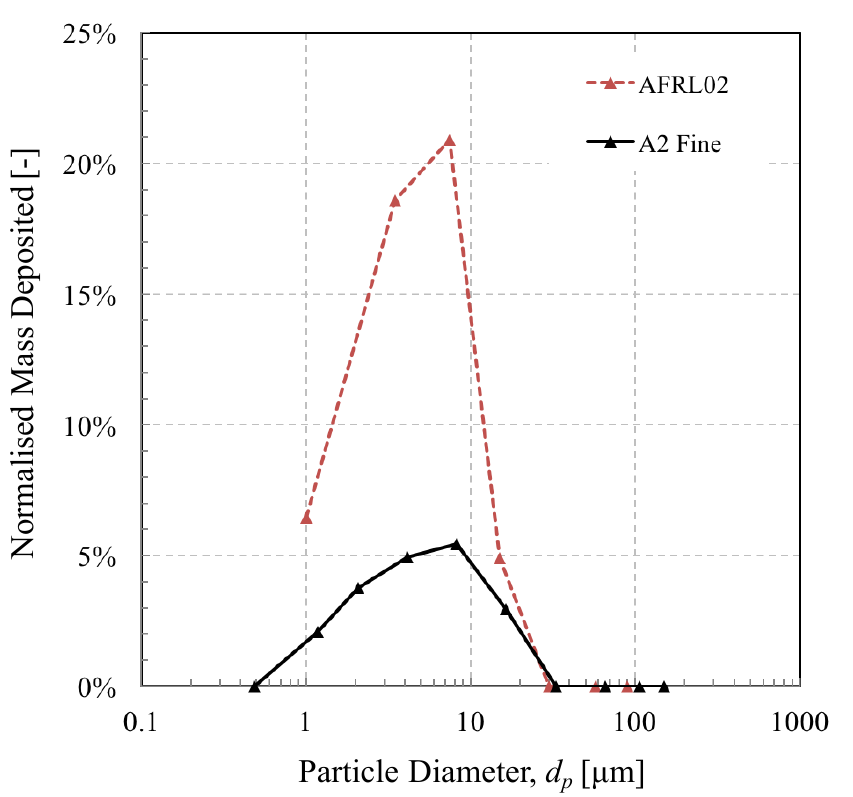
Figure 11. Percentage of deposited dust as a function of particle size for the two test dusts, normalised by the initial mass